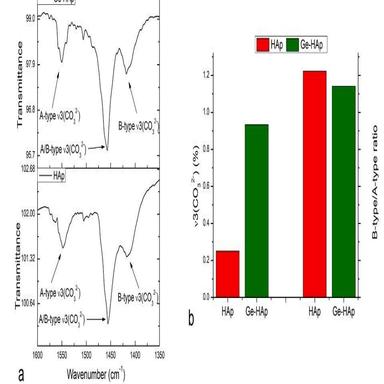
FTIR spectra of HAp and Ge-HAp in the 1600–1350 cm− 1 range, focusing on the antisymmetric ν3 stretch of the carbonate anion (a). The comparison of the calculated total percentage that the ν3 carbonate band occupies relative to the entire spectra of HAp and Ge-HAp (b, left Y-axis). The ratio of the B-type carbonate to the A-type carbonate in HAp and Ge-HAp (b, right Y-axis).